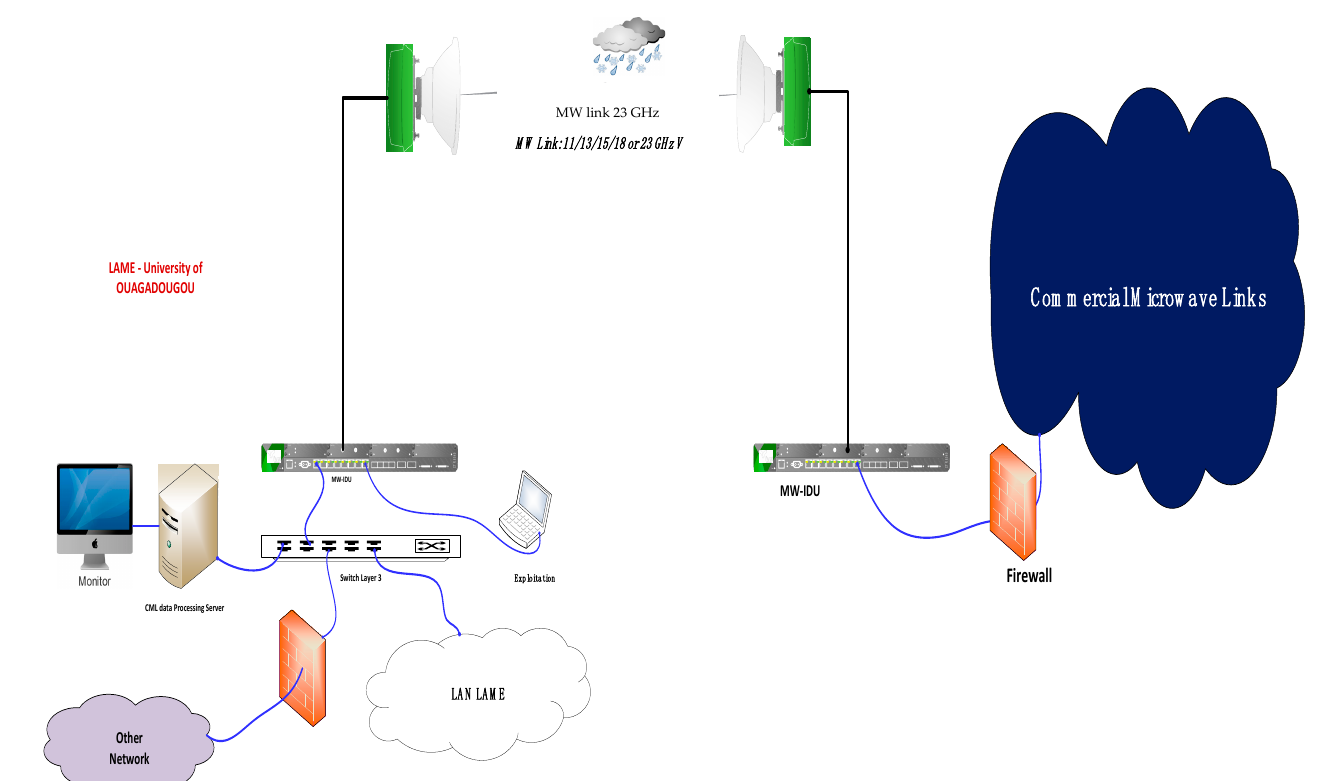
Figure 1. Schematic of Telecel Faso’s CML power data acquisition system.